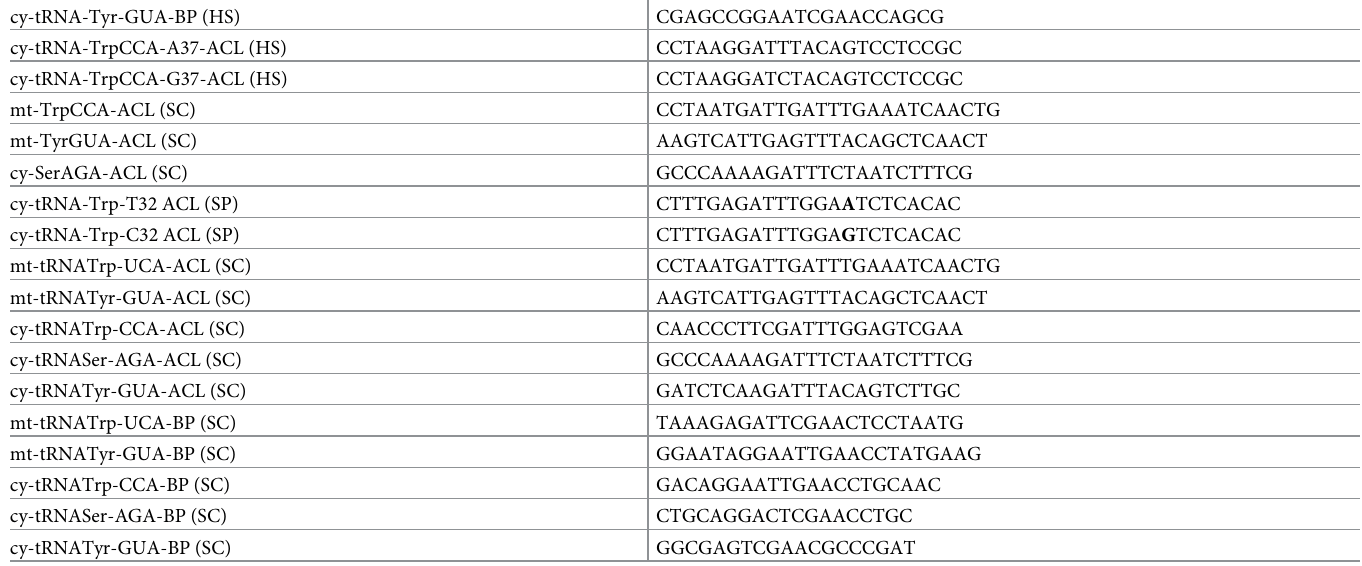
Table 2. Oligo-DNAs used for PHA6 assay; ACL (anticodon loop), BP (body